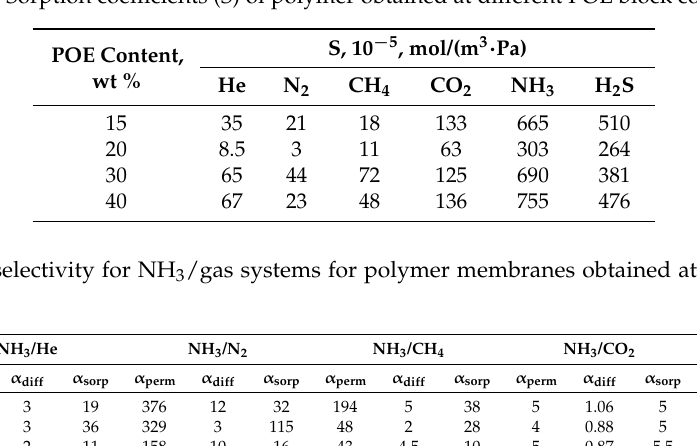
Table 3. Sorption coefficients (S) of polymer obtained at different POE block contents.